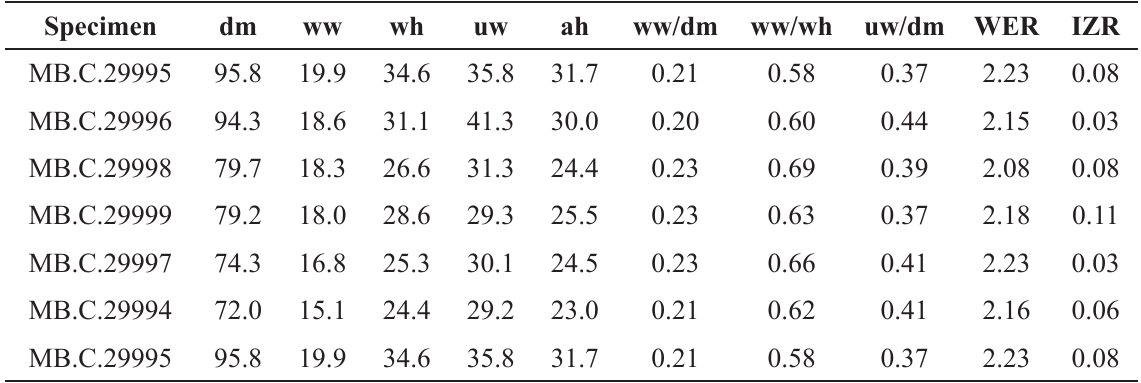
Table 26. Conch dimensions (partly estimated) and ratios of selected specimens of Lutites lyriformis Korn & Hairapetian gen. et sp. nov. from Baghuk